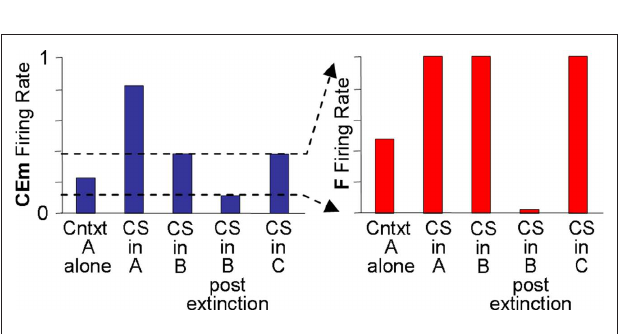
FigurE 3 | FrAT expression circuitry. Explanation in text. Reinf is input caused by US or other reinforcing events. The dashed direct pathway (ITC/BM/ CEl) from LA principal cells to CEm neurons is enabled by training in the absence of BL.